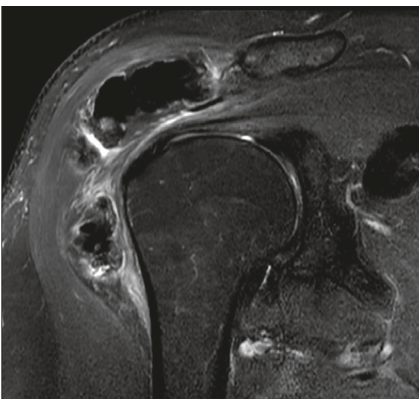
Figure 3: Magnetic resonance imaging of the left shoulder. Cor- onal T2 fat suppression image showing low-signal intensity calcific foci within and beneath the deltoid muscle with no intra-articular